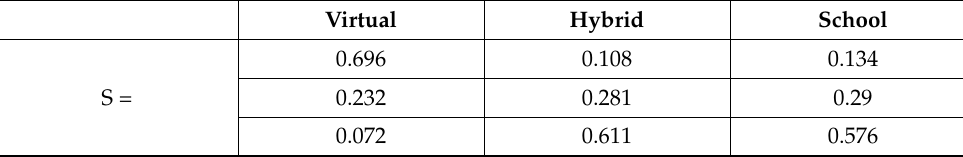
Table 8. 3 × 3 matrix – Black Box Solution for the 3 criteria and 3 alternative.